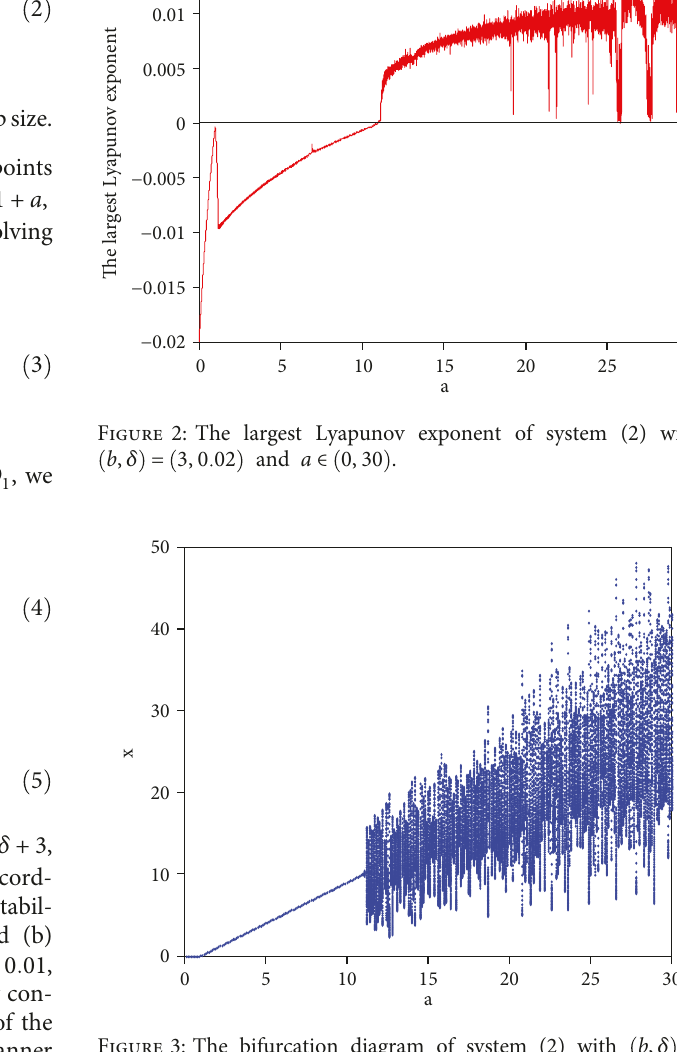
Figure 3: The bifurcation diagram of system (2) with b , δ = 3, 0 02 and a ∈ 0, 30